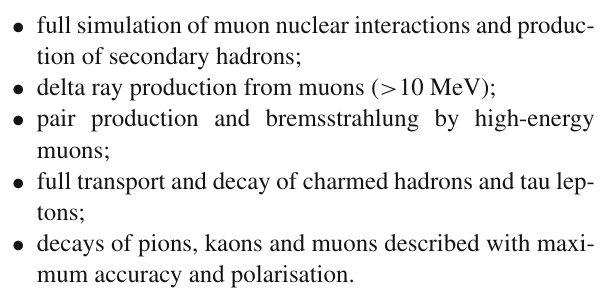
Fig. 10 Momentum distributions from FLUKA and GEANT4. The distributions are normalized to the number of POT